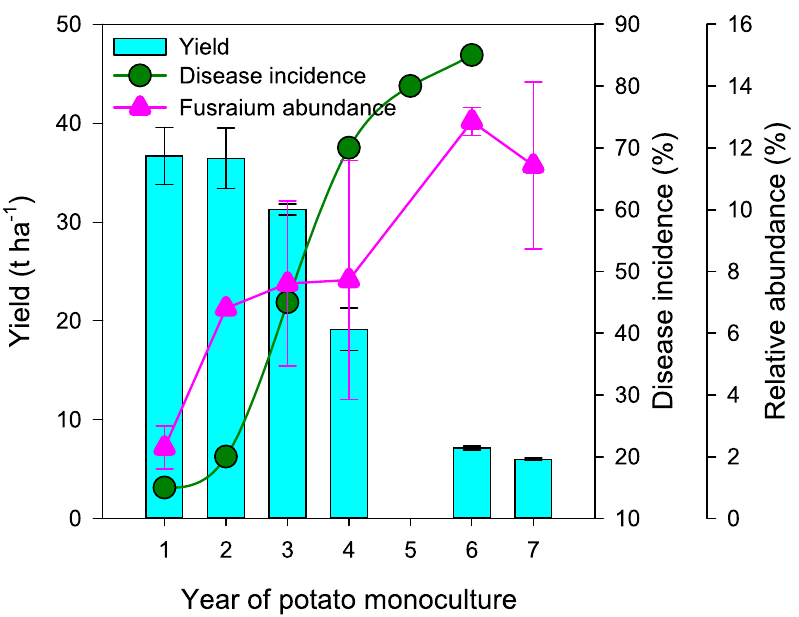
Figure 2. The change of potato yield, disease incidence and Fusarium abundance over the years of potato monoculture. Disease incidences shown in this figure were measured at harvest time.